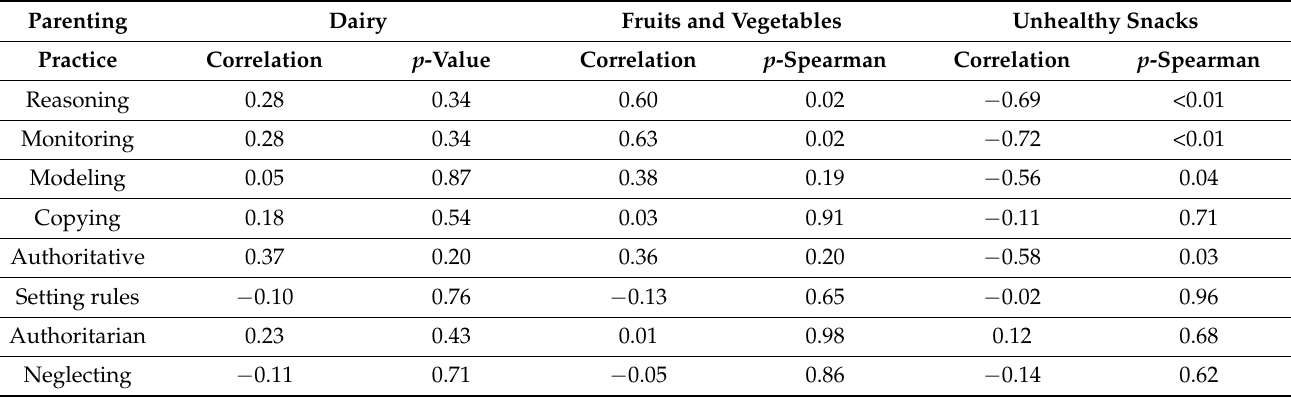
Table 6. Correlation between parenting practices and number of eating occasions by food category.